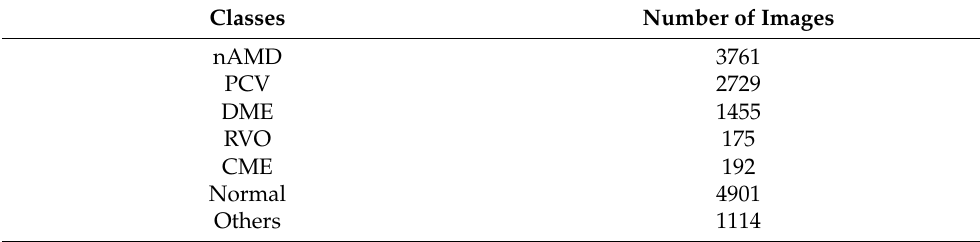
Table 1. The distribution of OCT images assigned to each